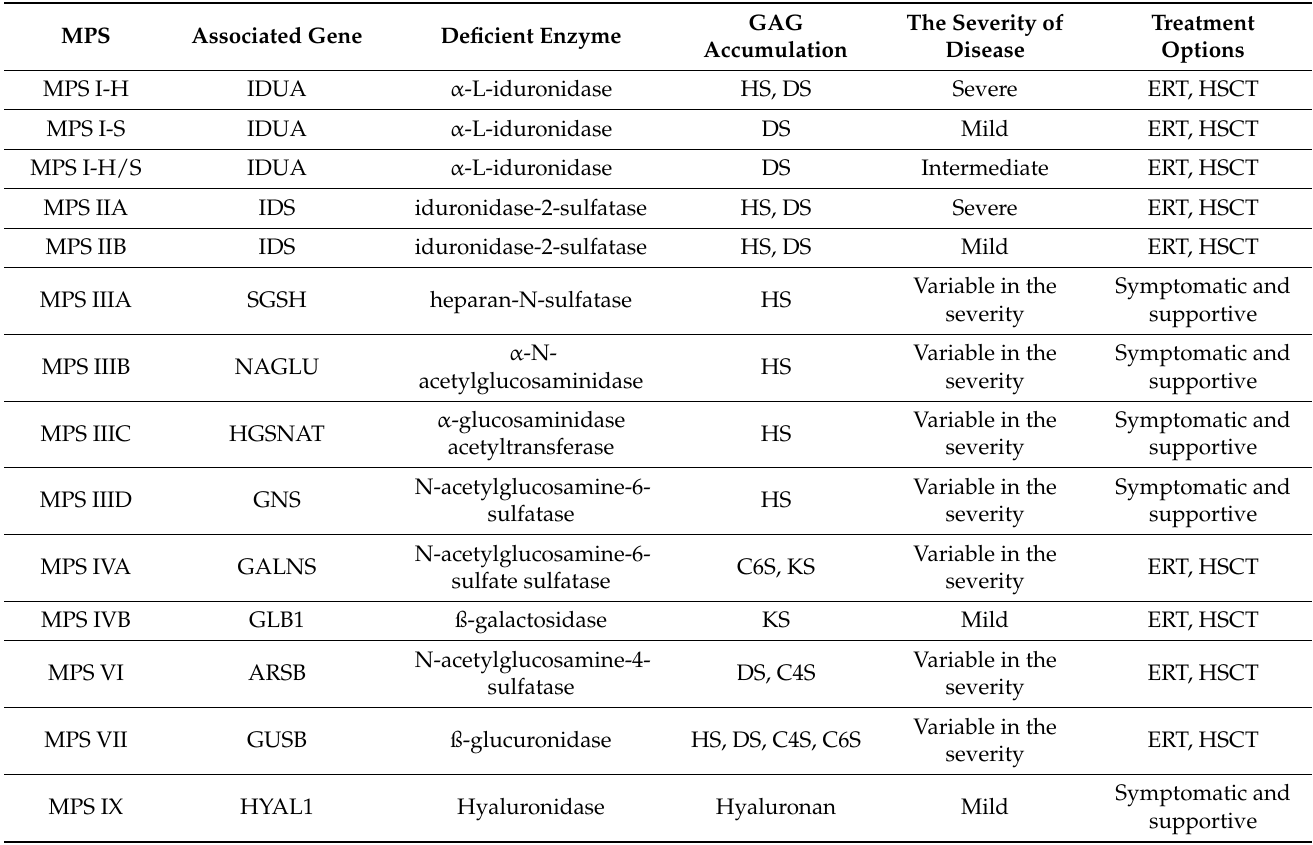
Table 1. General characteristics of